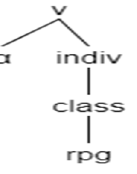
Figure 7. Geometry of the lexical features δ and affectedness.